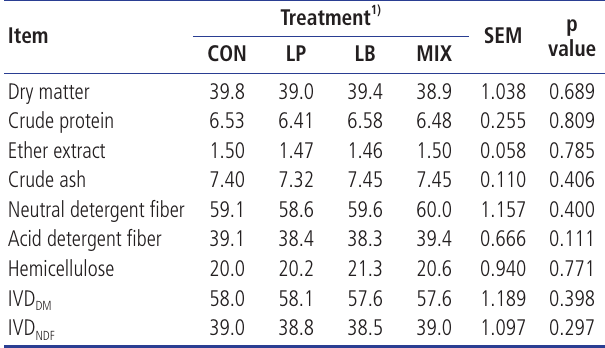
Table 1. Effects of homo and hetero fermentative inoculants on chemical composition and in vitro digestibility of fresh sweet potato vine with Italian ryegrass hay (%, dry matter)